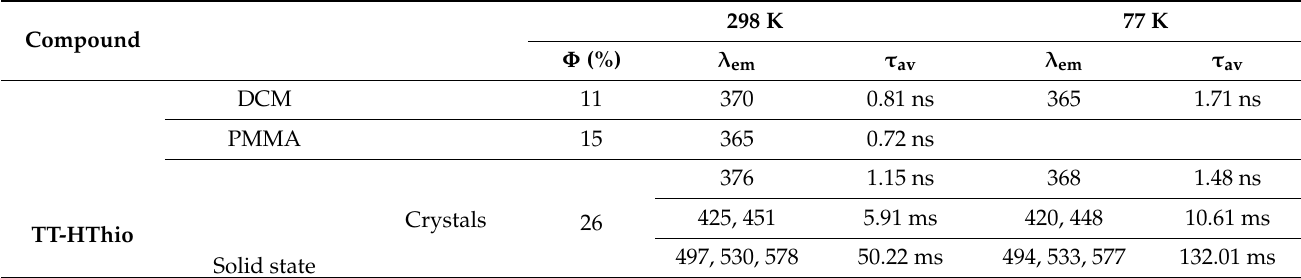
Table 1. Photophysical parameters of TT-HThio and TT-(HThio) 3